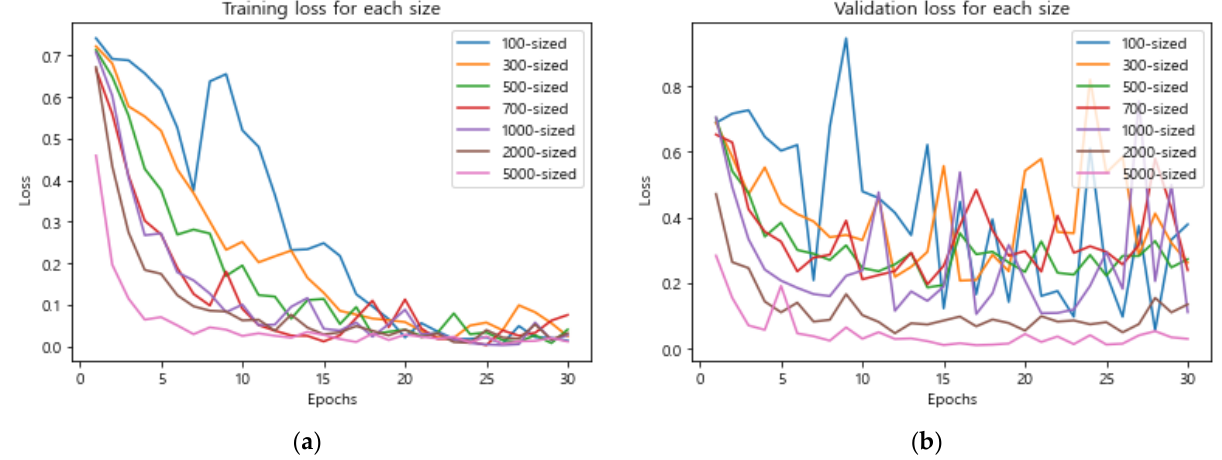
Figure 4. ( a ) Loss change in training set for each size; ( b ) loss change in validation set for each size.